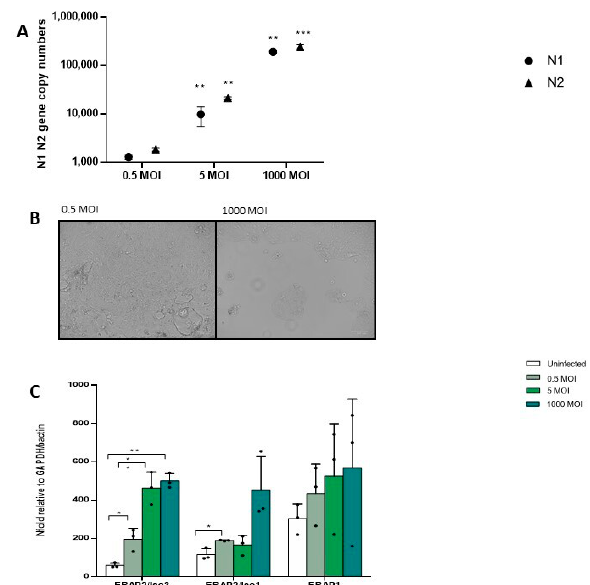
Figure 4. In vitro SARS-CoV-2 infection assay on Calu3 cells. ( A ) SARS-CoV-2 replication was assessed on Calu3 cells infected at 0.5, 5, and 1000 MOI 48 h post-infection. Viral copy number quantification was performed by generating a standard curve from the quantified 2019-nCoV_N positive plasmid control for Nucleocapsid (N) region 1 and 2, showing a significant increase in response to the increased viral input. ( B ) SARS-CoV-2-induced cytopathic e ff ects were assessed in Calu3 infected cells. Representative images of SARS-CoV-2 infected-cells at 0.5 and 1000 MOI are reported. At 48 h post-infection, typical cytopathic e ff ects, including cell rounding, detachment, degeneration, and syncytium formation were seen only in cells infected at 1000 MOI. Cells were imaged by optical microscope observation (ZOE ™ Fluorescent Cell Imager, Bio-Rad, Hercules, CA, USA). ( C ) ERAP2 / Iso3, Iso1, and ERAP1 mRNA expression by in vitro SARS-CoV-2 infected Calu3 cells increased according to the rising viral input. Mean values ± ES are reported. * = p < 0.05; ** = p < 0.01; *** = p < 0.001. MOI = multiplicity of infection.